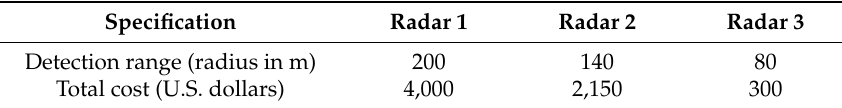
Table 2. Attributes of radar